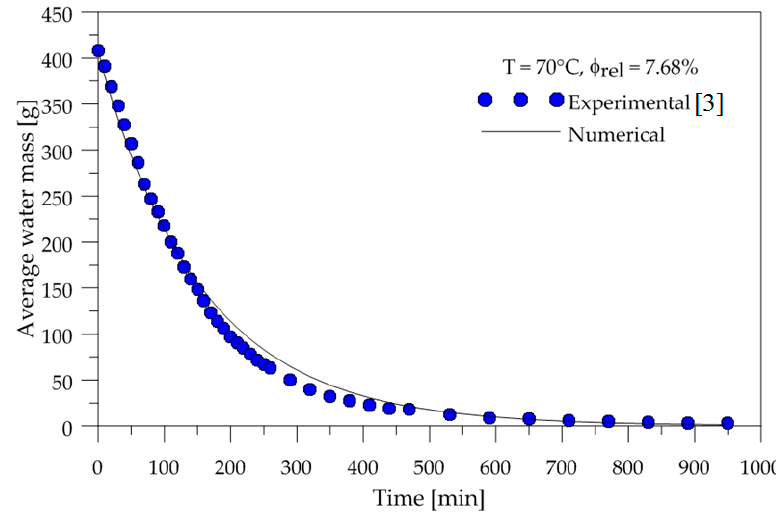
Figure 4. Average water mass inside the brick as a function of time.